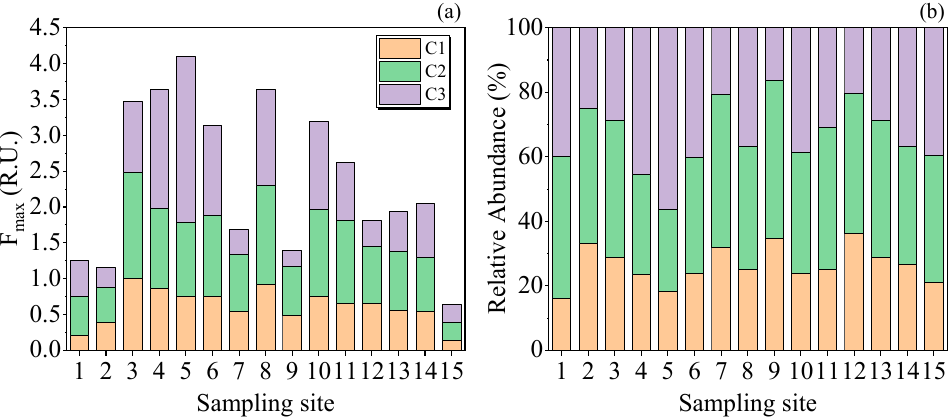
Figure 5. Distribution of the ( a ) abundance and ( b ) relative abundance of three PARAFAC components of the sediment samples in Wuhan; 1–14 refer to the urban streams, 15 refers to the reference. The relative abundance of three fluorescence components is displayed in Figure 5b.